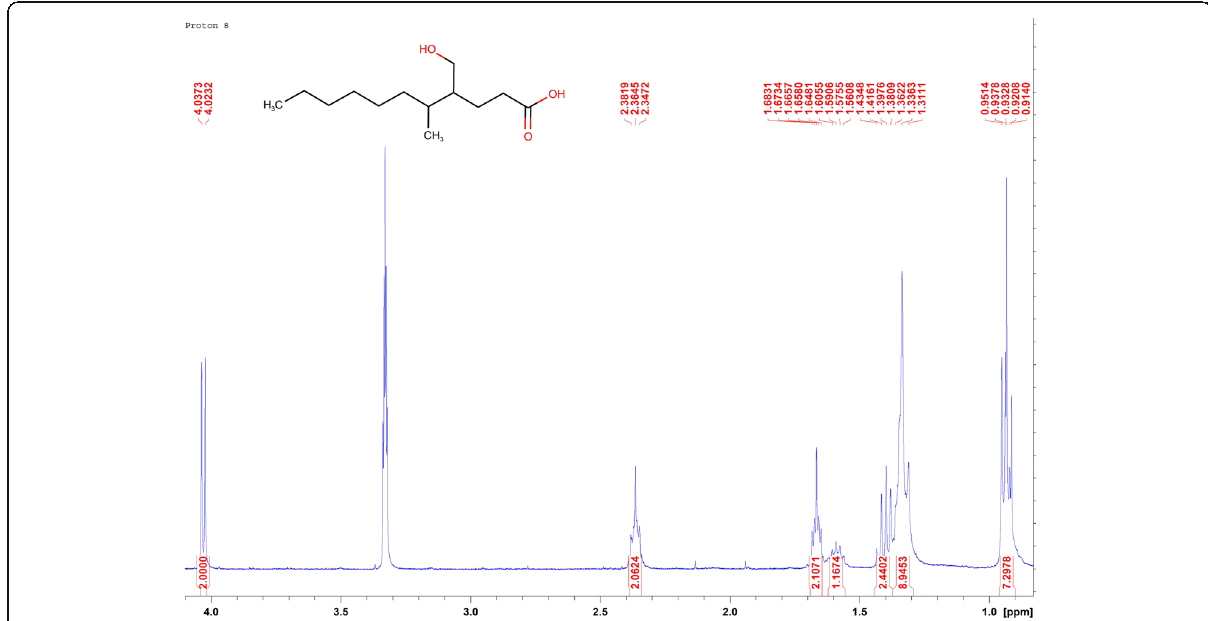
Fig. 3 1 H NMR spectroscopy of the major compound in fraction 8 in